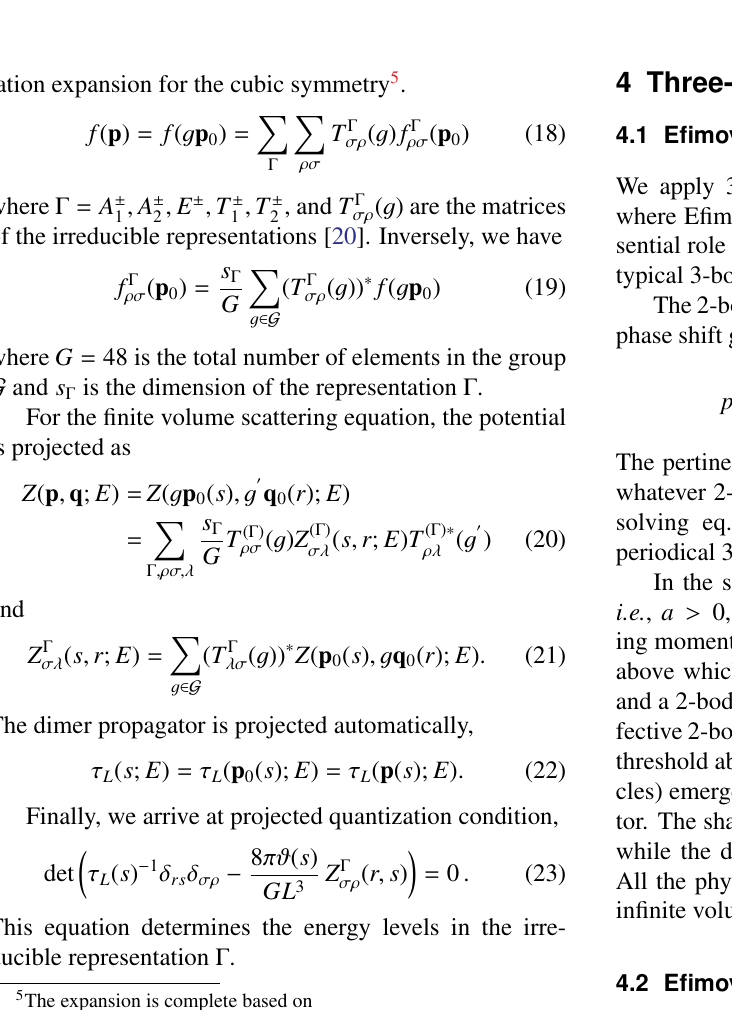
Figure 8: The left plane: 3-body force H 0 is running as momentum cut-o ff Λ in the log-periodical manner. The right plane: Efimov states, a is 2-body scattering length (1 / a = 0 corresponding to unitary limit), K is 3-body energy, AAA means 3-atom state, AD is the state of a spectating atom and a 2-atom bound state, T means 3-body bound state, i.e. , Efimov state. The vertical dashed line shows the system we are concerning.